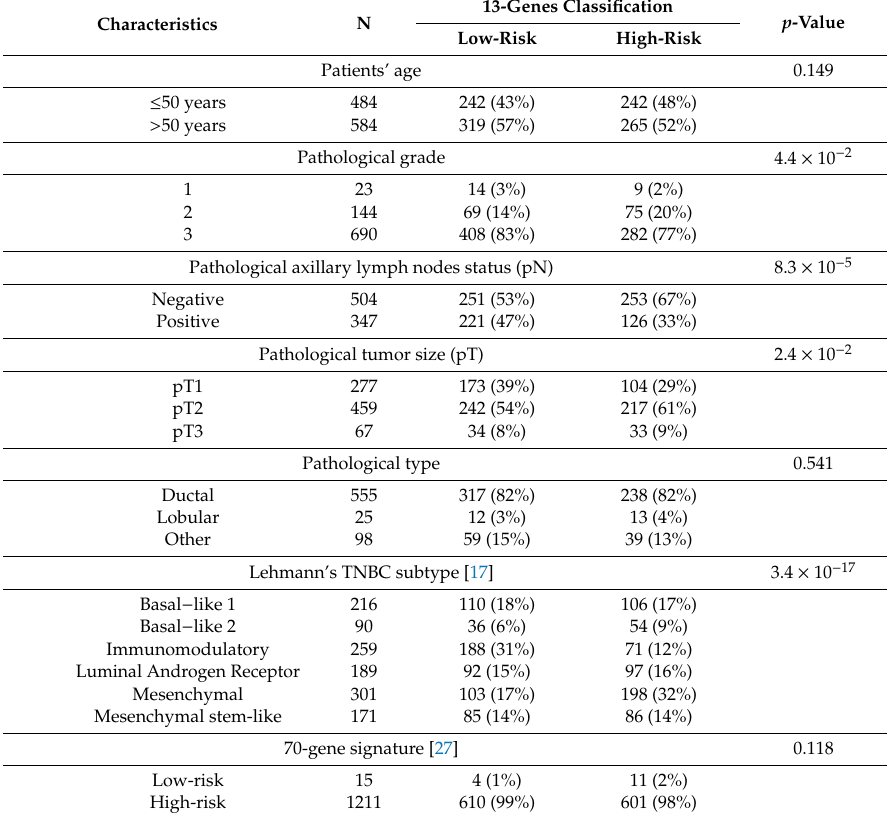
Table 2. Correlations of our 13-gene classification with clinicopathological and molecular